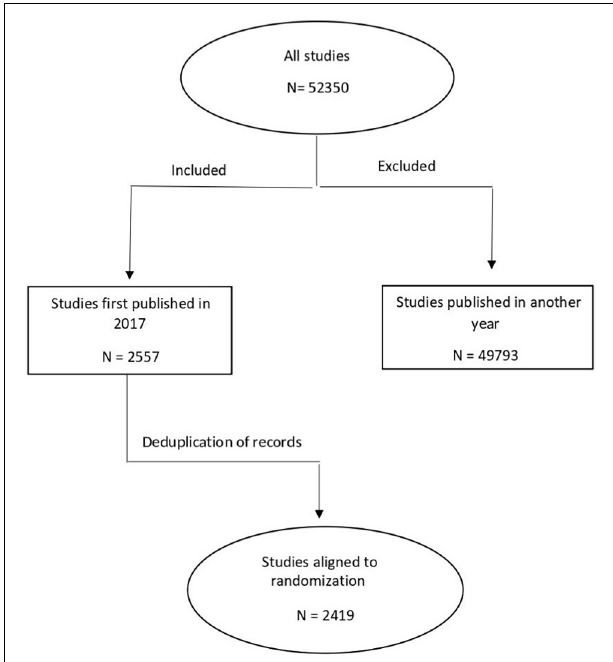
FIGURE 1 | Flowchart of study selection.